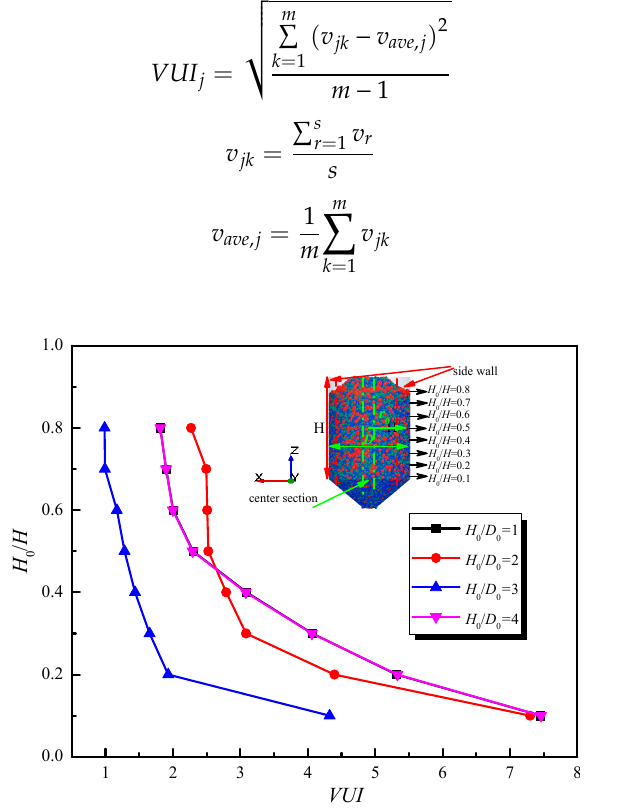
Figure 7. Evolution of velocity uniformity index ( VUI ) in sinter layers with different aspect ratios.